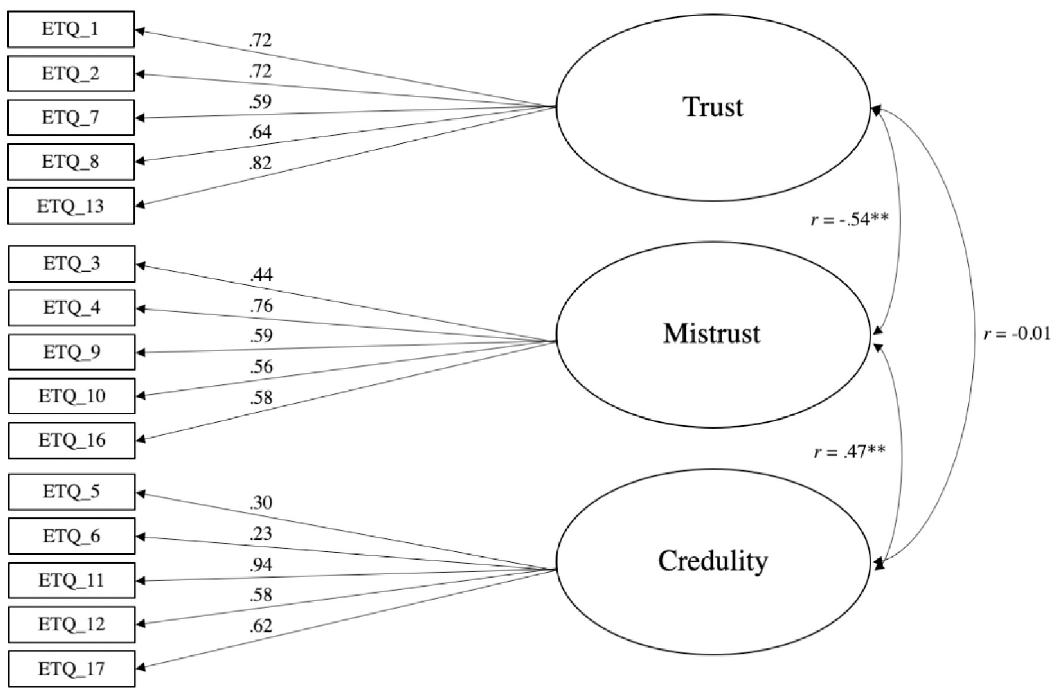
Fig 1. CFA with factor loadings from Study 1 (model 4, 15 items). Loadings are standardized. Rectangles indicate measured variables and circles represent latent constructs. Note the item numbering is retained from the original 18-item scale. � p < .05. �� p <